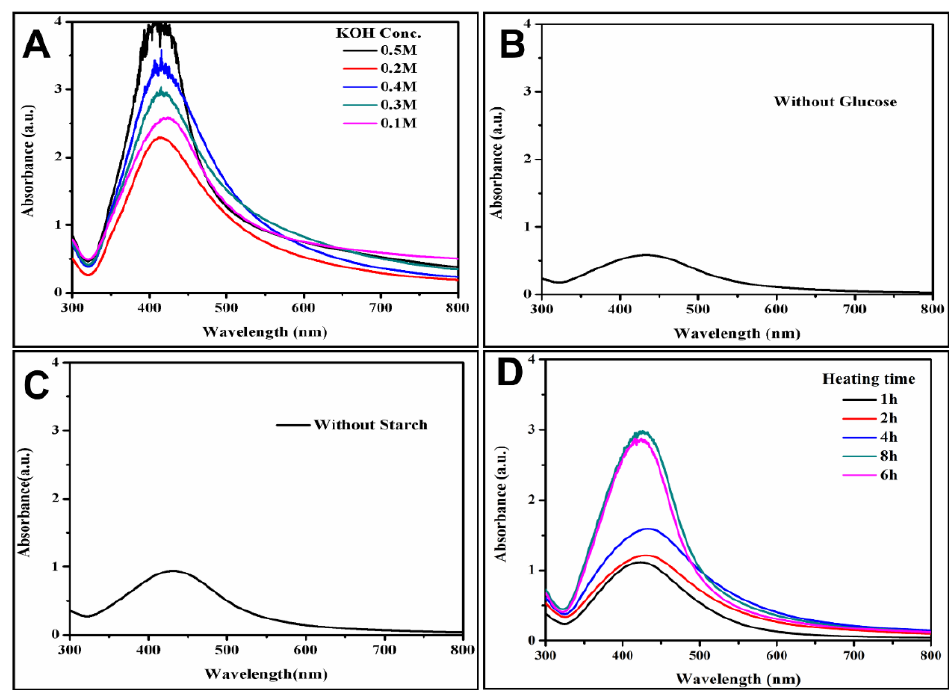
Coatings 2022 , 12 , x FOR PEER REVIEW 9 of 16 Figure 3. UV spectrum shows AgNPs formation, ( A ) at 0.02 mL of different concentrations of KOH, ( B ) without 2 mL of glucose, ( C ) without 2 mL of starch, ( D ) without 0.02 mL of KOH.